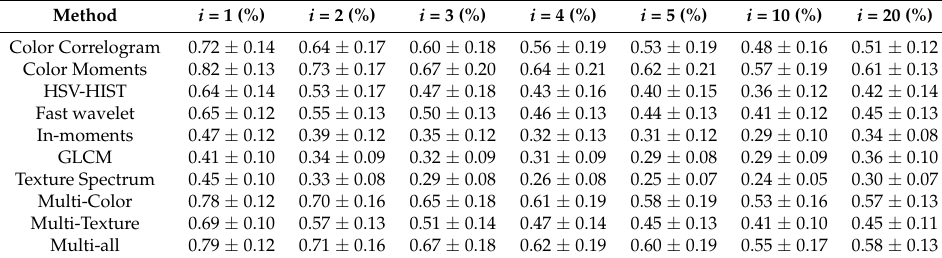
Figure 5. Remote sensing database: samples of three pairs of images for each of the 9 change classes. Table 3. Comparison of different methods: Coverage Rate.